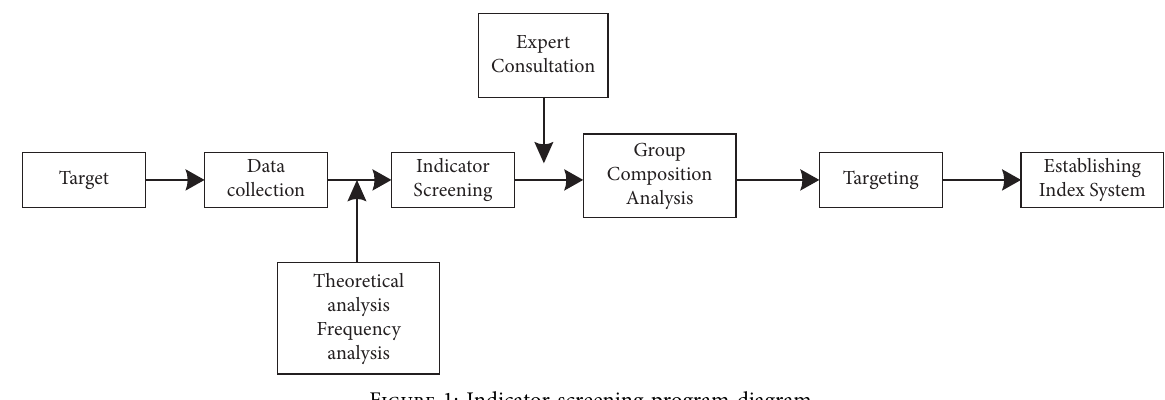
Figure 1: Indicator screening program diagram. Table 1: Index system for assessing the ecological carrying capacity of urban agglomerations in Britain